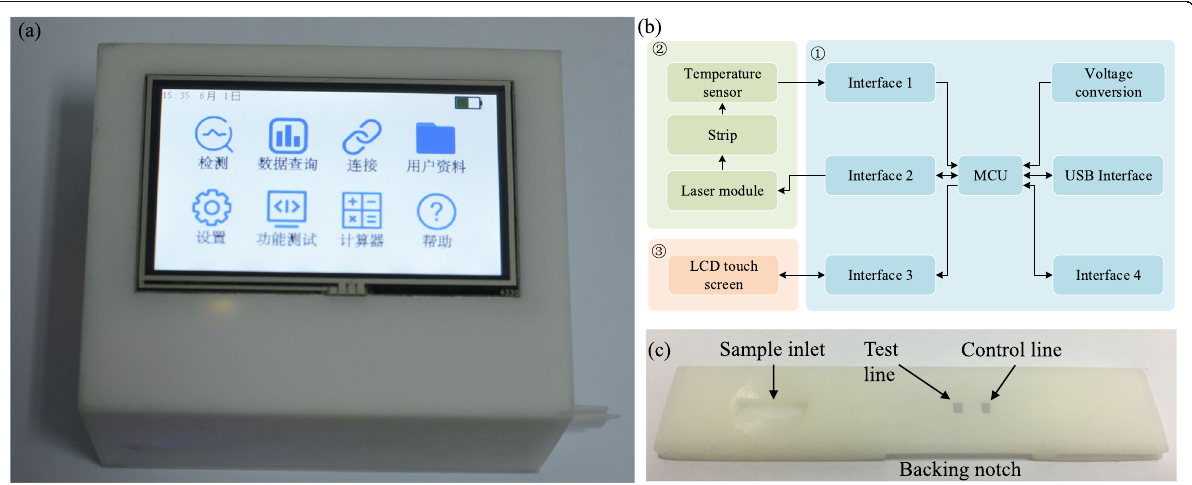
Fig. 1 Details of portable device. a Plasmonic thermal sensing based portable device. b Hardware composition diagram ① mother board, ② laser and sensing module, and ③ user interface. c Cartridge for